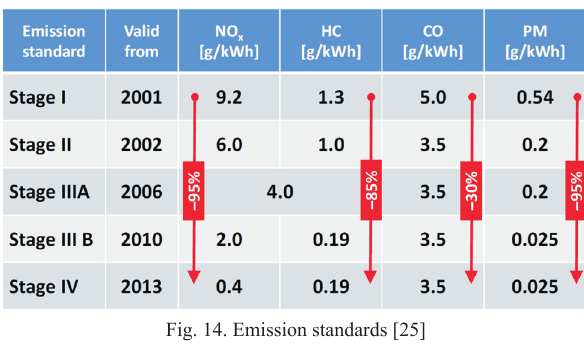
Fig. 14. Emission standards [25]